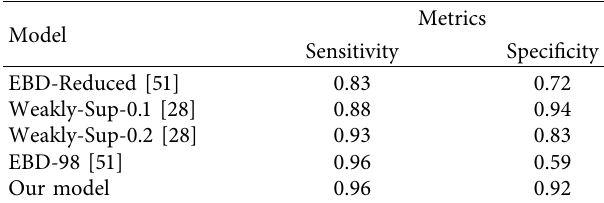
Table 3: Performance analysis of semisupervised learning.